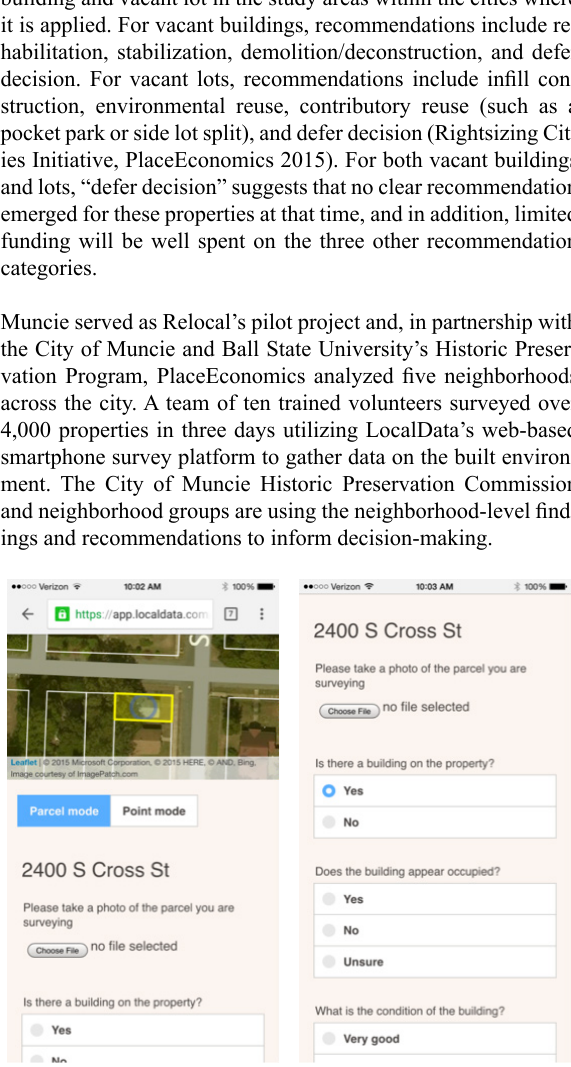
Figure 4. Screenshots of the web-based LocalData survey plat- form utilized in the Relocal projects (Source: PlaceEconomics and LocalData,